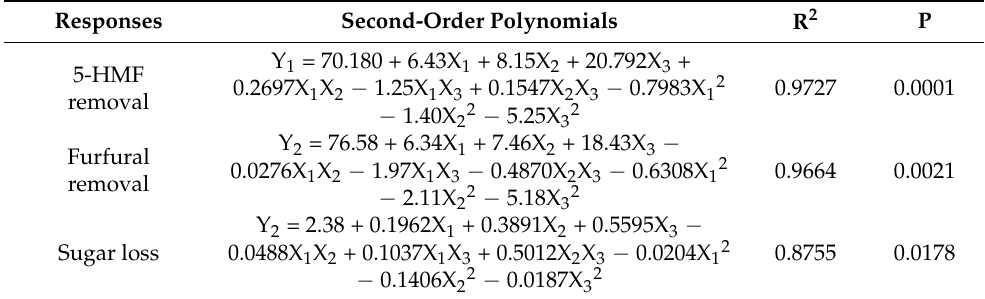
Table 4. Second-order polynomial equations calculated by central composite design for the optimiza- tion of the detoxification